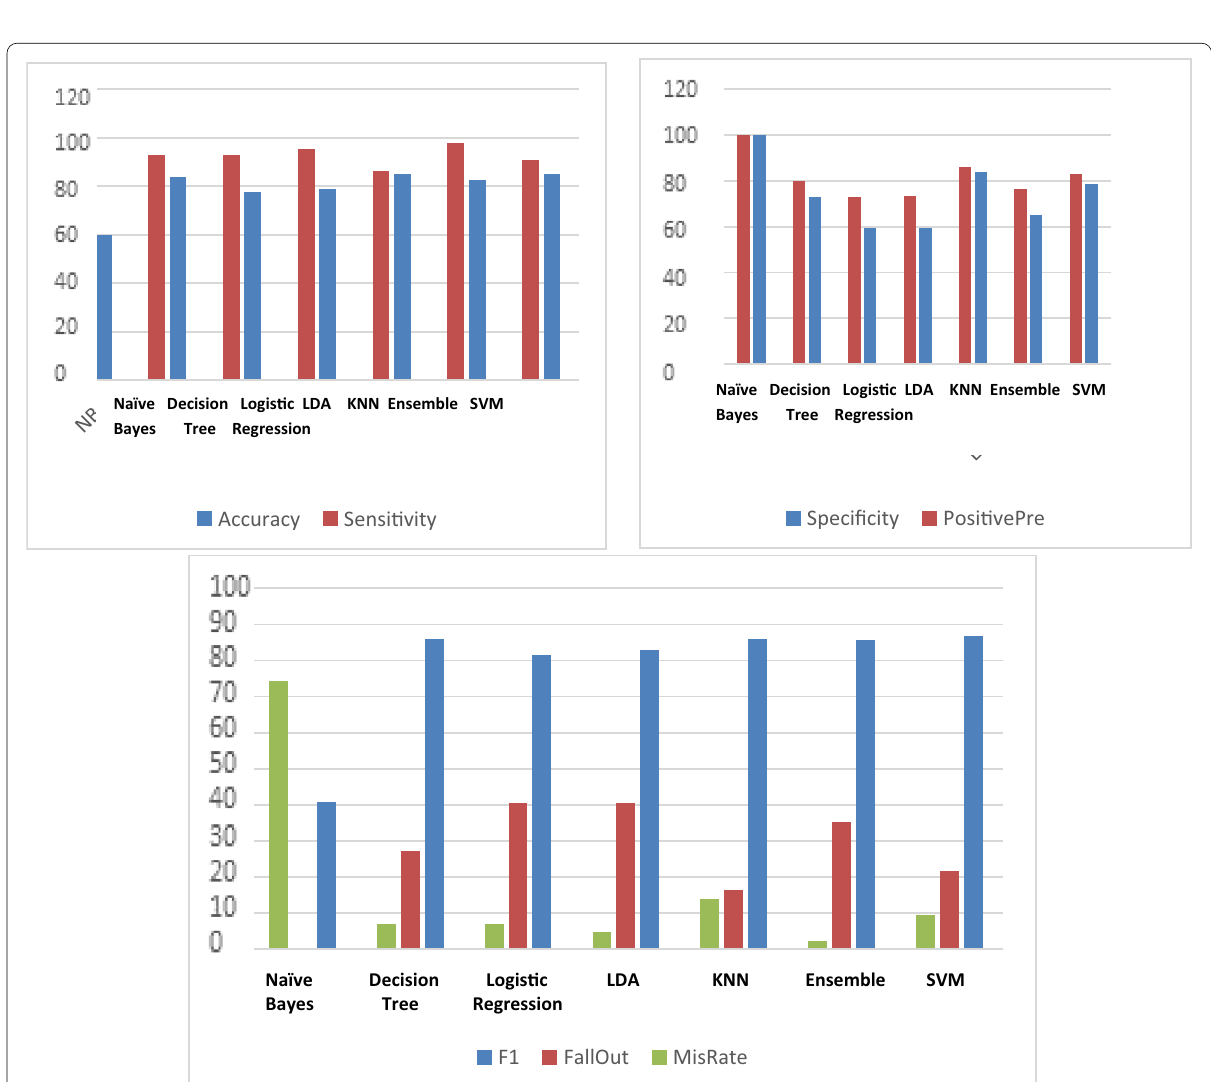
Fig. 4 Evaluation of the metric parameters for the seven classifiers of the random case testing